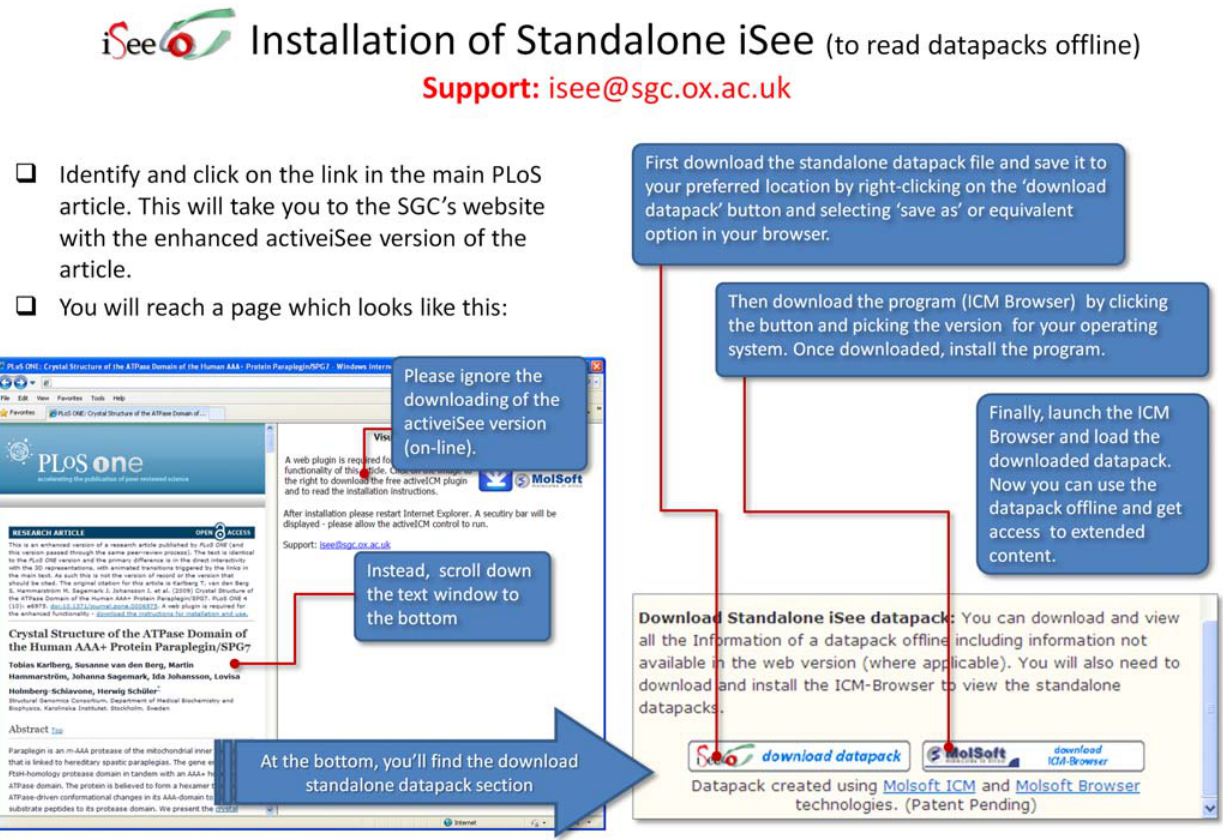
Figure 2. Reading the iSee version of the articles offline - first-time installation instructions.